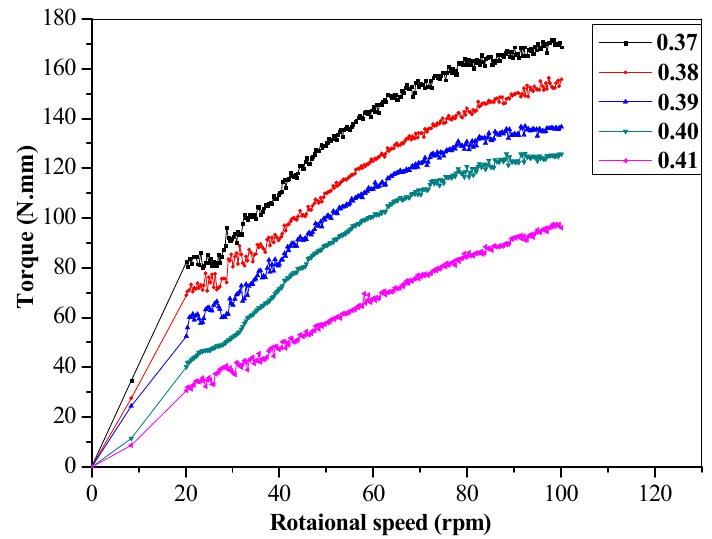
Figure 4. Torque versus rotational speed.